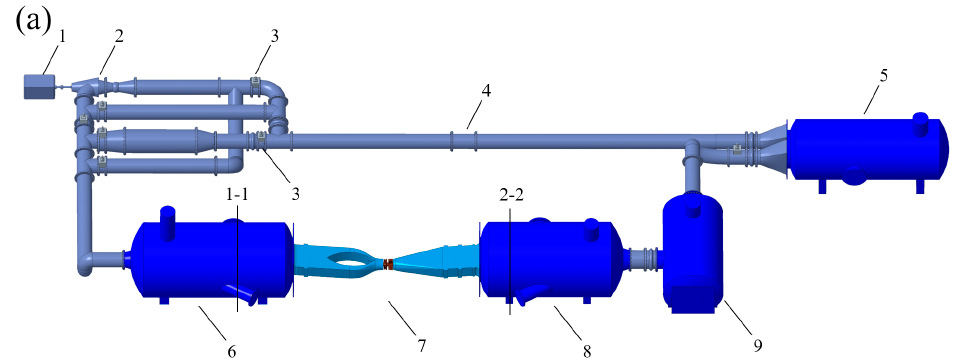
Table 1. Test equipment and related parameters.